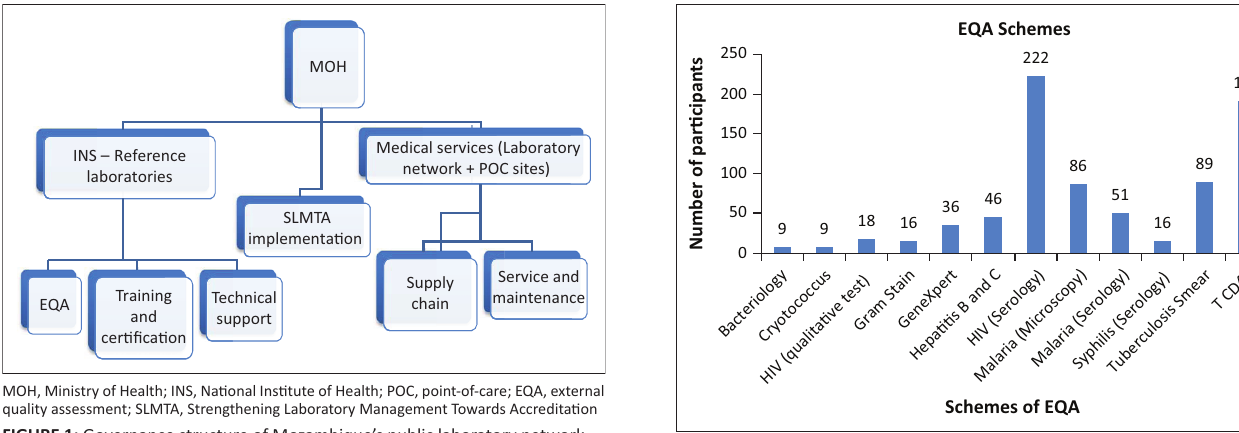
FIGURE 2: Schemes for external quality assessment (EQA) in Mozambique,